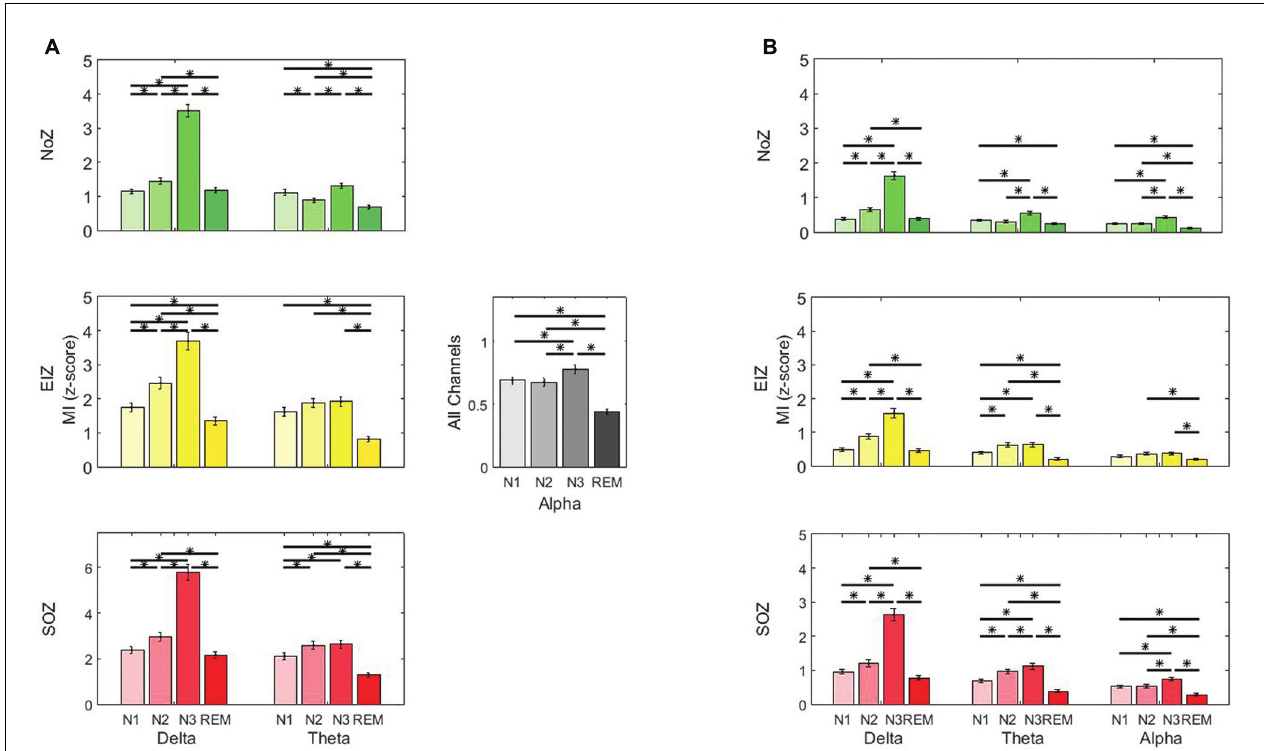
FIGURE 3 | Average phase-amplitude coupling (PAC) quantified by modulation index (MI) (A) gamma band and low frequencies, (B) ripple band and low frequencies. Green: normal zone (NoZ), Yellow: exclusively irritative zone (EIZ), Red: seizure onset zone (SOZ), Gray: all channels. ∗ Shows significant difference ( p < 0.05, corrected). The order: N1, N2, N3, REM, from light to dark color. Results are plotted as the mean ±